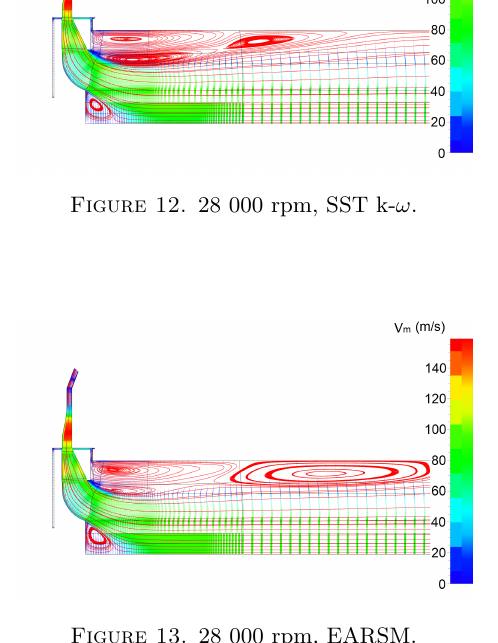
Figure 13. 28 000 rpm, EARSM.